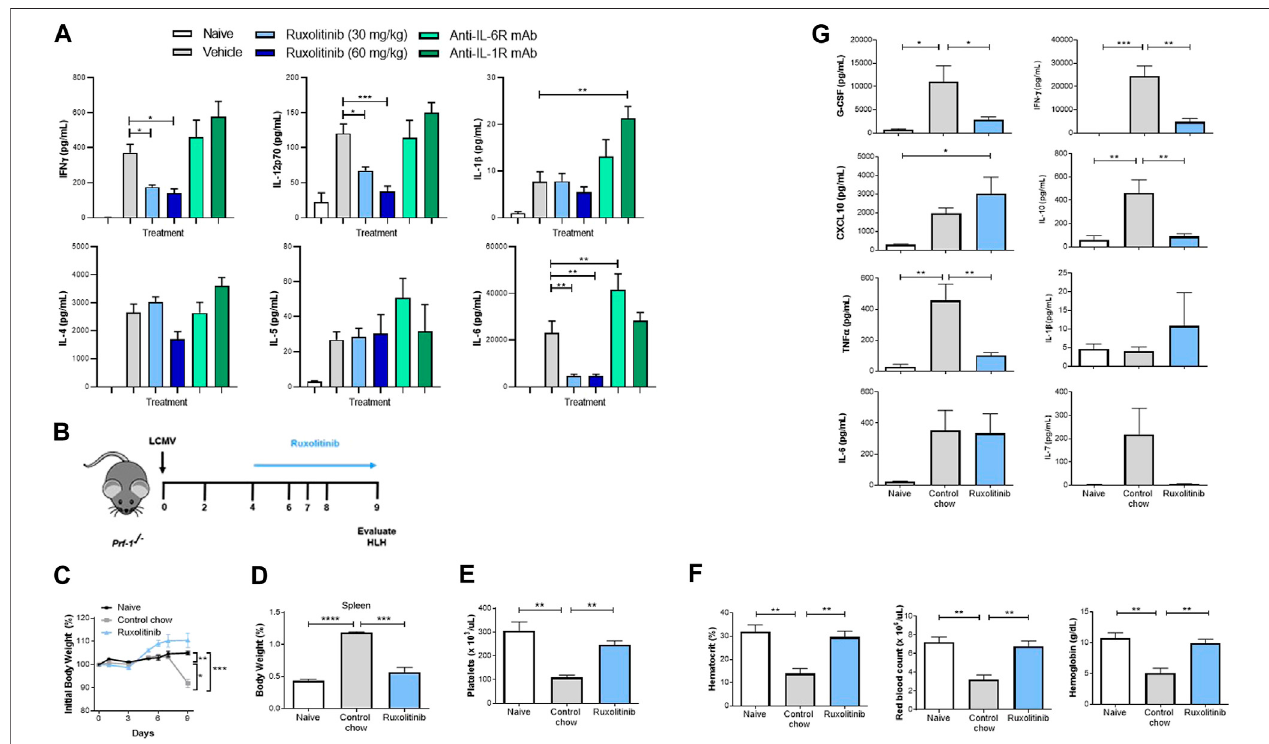
FIGURE 1 | Ruxolitinib lowers cytokine levels in murine models of acute in fl ammation (A) BALB/c mice were challenged with Con-A and dosed 30 min later with vehicle control, 30 or 60 mg/kg of ruxolitinib, anti-IL-1 mAb (25 mg/kg), or anti-IL-6R mAb (25 mg/kg). Animals were sacri fi ced 120 min later, and serum was collected. Multiplexcytokineanalysiswasperformedtoquantifyproin fl ammatorycytokineconcentrations (B) Prf1 − / − micewereinfectedwithLCMVandtreatedwitheithercontrol chow or ruxolitinib chow (ruxolitinib) starting on day 4 post-infection. Mice were euthanized on day 9 post-infection (C) Kinetics of body weight percentage in treatment-naive, control chow-treated, and ruxolitinib-treated mice (D) Spleen percentage of body weight in treatment-naive, control chow-treated, and ruxolitinib- treated mice (E,F) Blood analysis showing number of PLTs, HCT, levels of HB, and RBC counts (G) Levels of serum cytokines. N (cid:2) 5 animals per group. Data